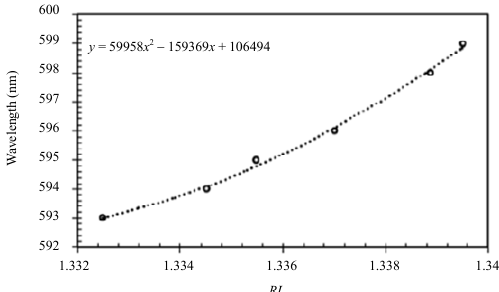
Fig. 9 Theoretical response for the different cladding RIs for the followed design approach.